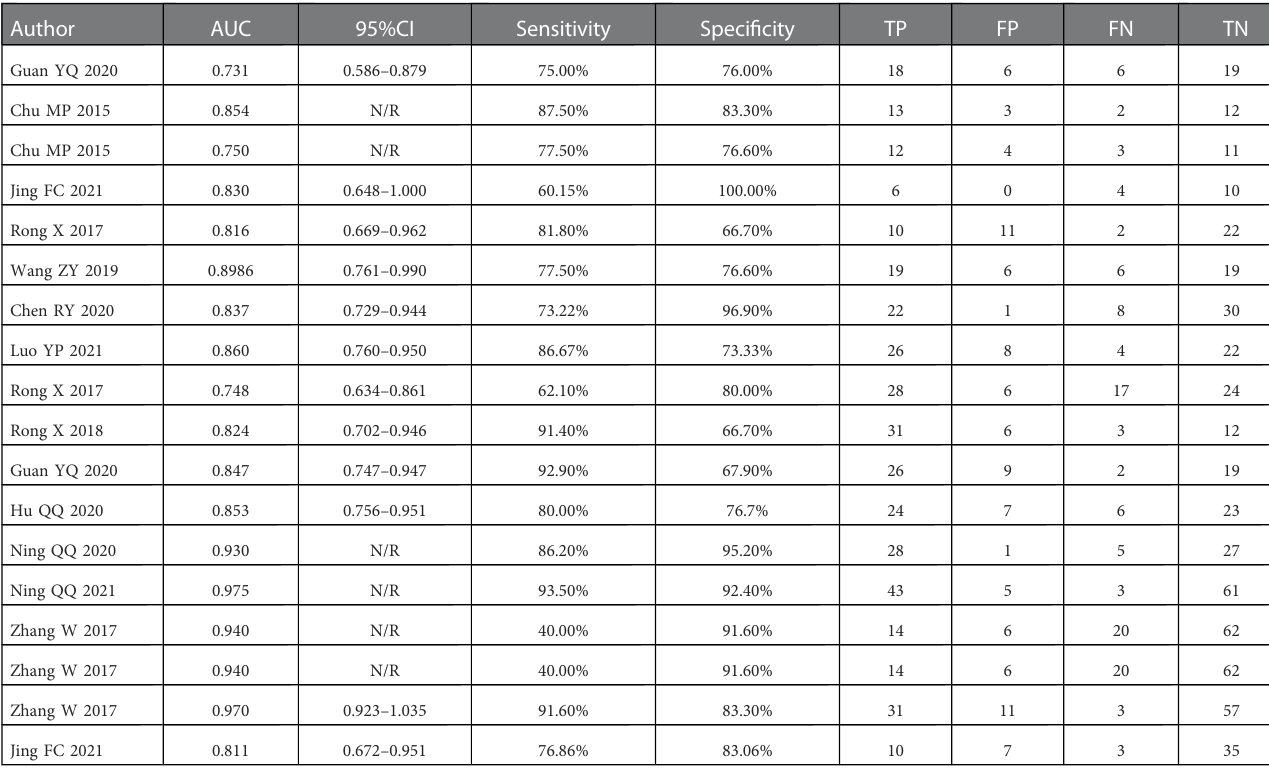
TABLE 2 Main characteristics of the included